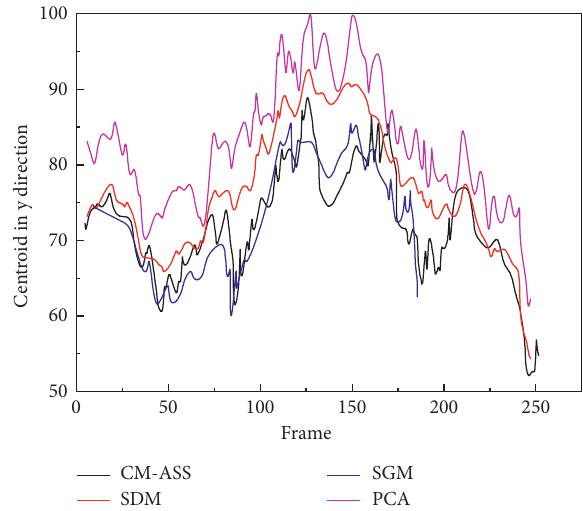
Figure 6: Comparison of trace results on